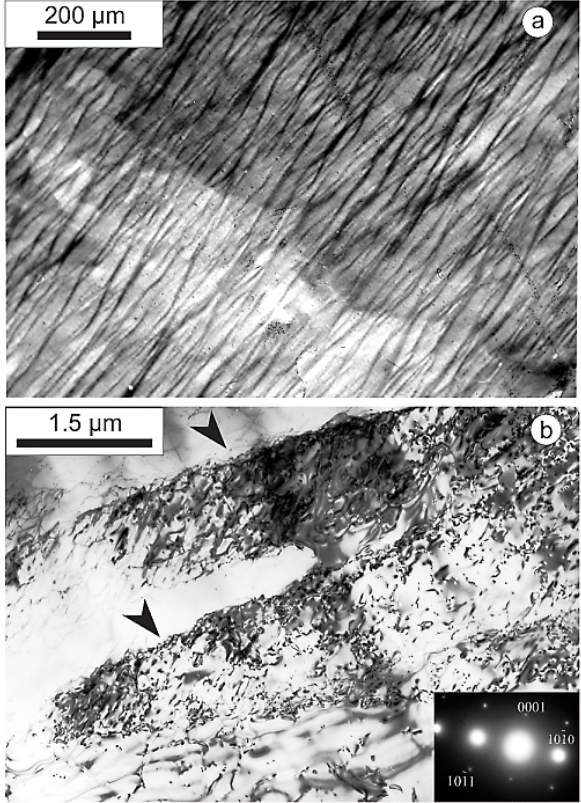
Fig. 10. Microstructures of naturally deformed vein quartz from St. Paul la Roche, France. (a) Polarized light micrograph showing pro- nounced SWUE. (b) TEM bright field micrographs of foil prepared by ion milling from region displayed in (a) . Poorly ordered dislo- cation walls (arrows) confine domains with a width of about 1µm, with dislocations being in or out of contrast at slightly different tilt, indicating differing crystallographic orientation. Dislocation den- sity is on the order of 10 13 m − 2